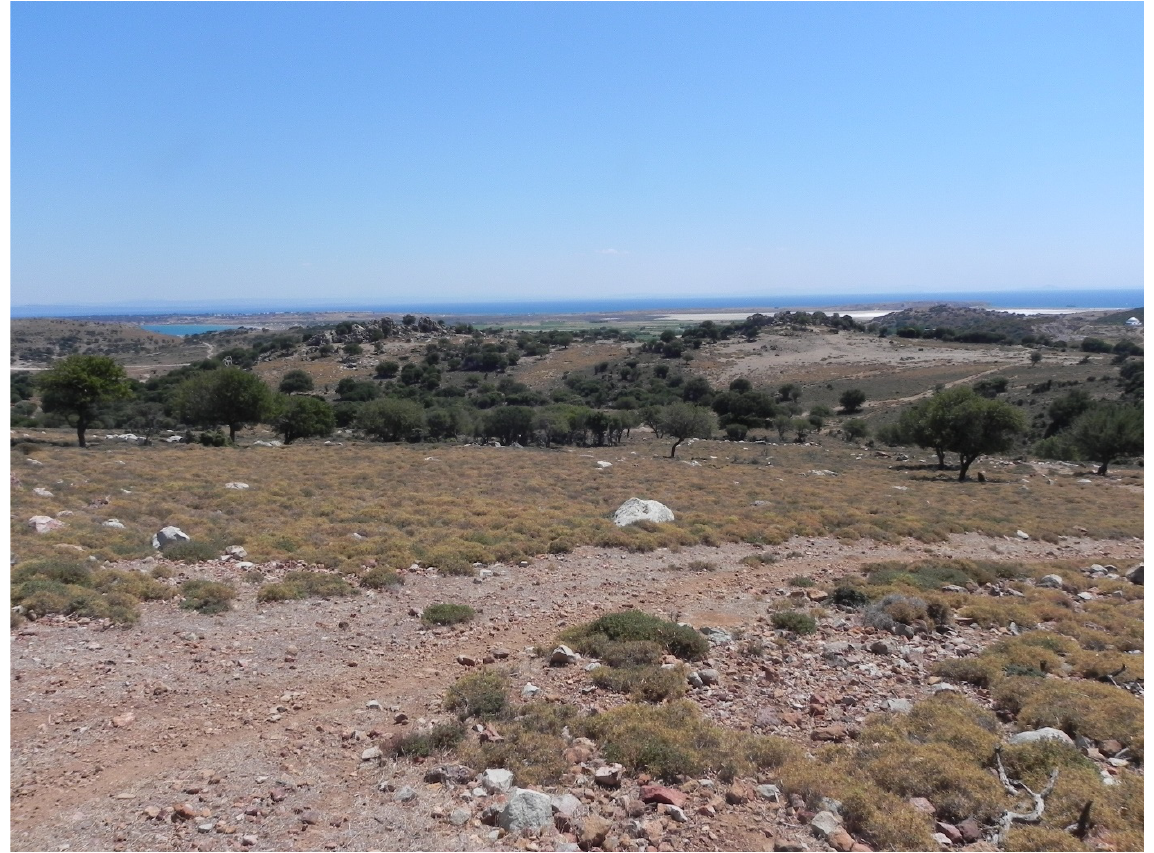
Figure 2. General View from Eksino Stream